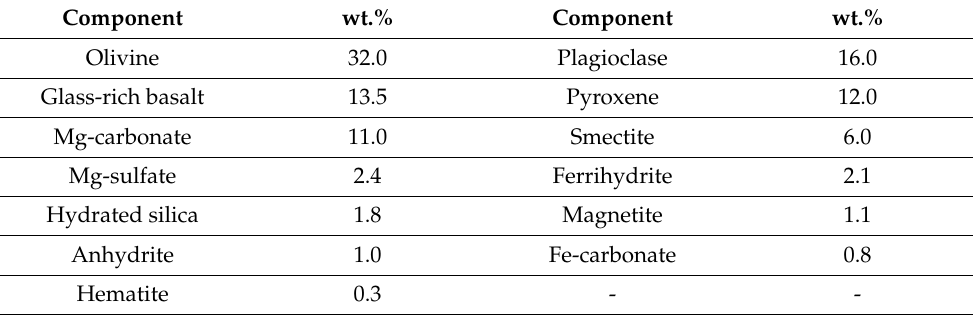
Table 1. Mineralogy of JEZ-1 (results from Exolith Lab). Component